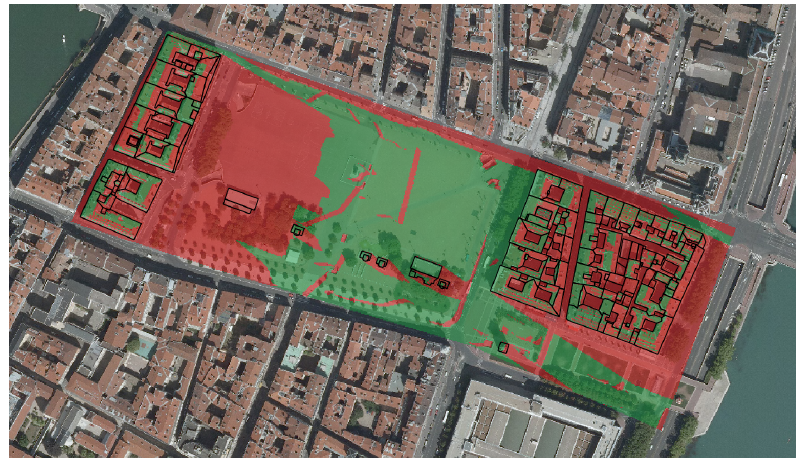
Figure 18. Raster analysis results regarding the visibility of the Fourvière Basilica (Bellecour Square). Green pixels indicate areas where the Basilica can be seen, and red pixels indicate places from which it is not visible. The results are displayed on an aerial image with a little transparency. Building footprints are represented in black.